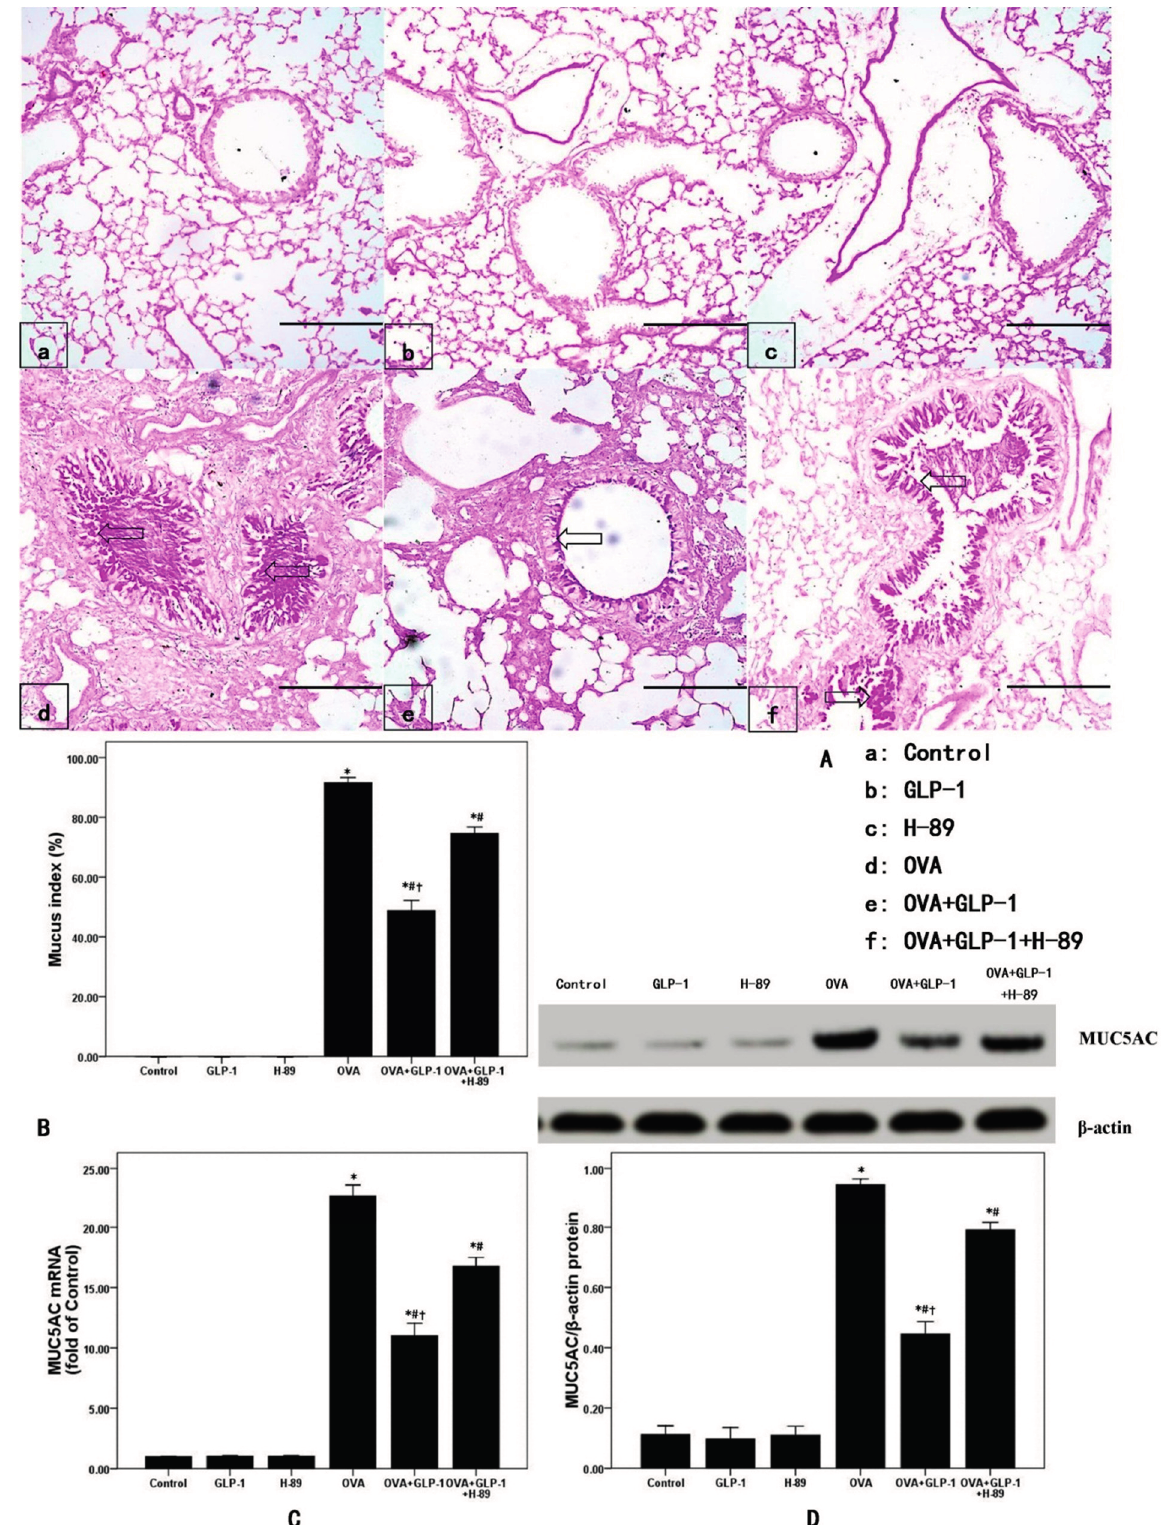
Figure 4. GLP-1 inhibits airway mucus secretion in OVA-induced chronic asthma. ( A ) After 81 days of OVA sensitization and challenge, mice were sacrificed and their right lower lungs were fixed. Then, tissue sections were stained with periodic acid-Schiff (PAS) staining. The Figure demonstrates a representative view (×200) from each group; (Mucus (open arrows)); Scale bar = 100 μ m; ( B ) the mucus index was calculated as the percentage of the